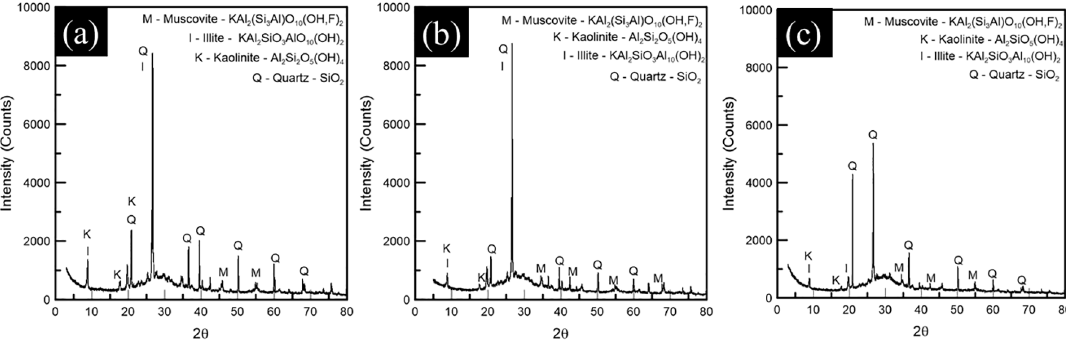
Figure 4. Diffractograms of: (a) 100MK; (b) 80MK20SF; and (c) 60MK40BFS.